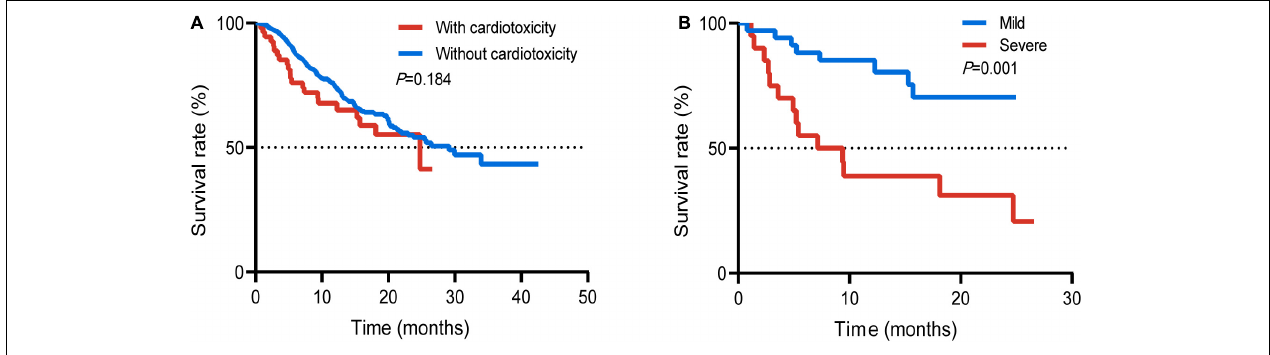
FIGURE 3 | Survival curve of the whole population with or without cardiotoxicity (A) ; patients with mild or severe cardiotoxicity (B) .